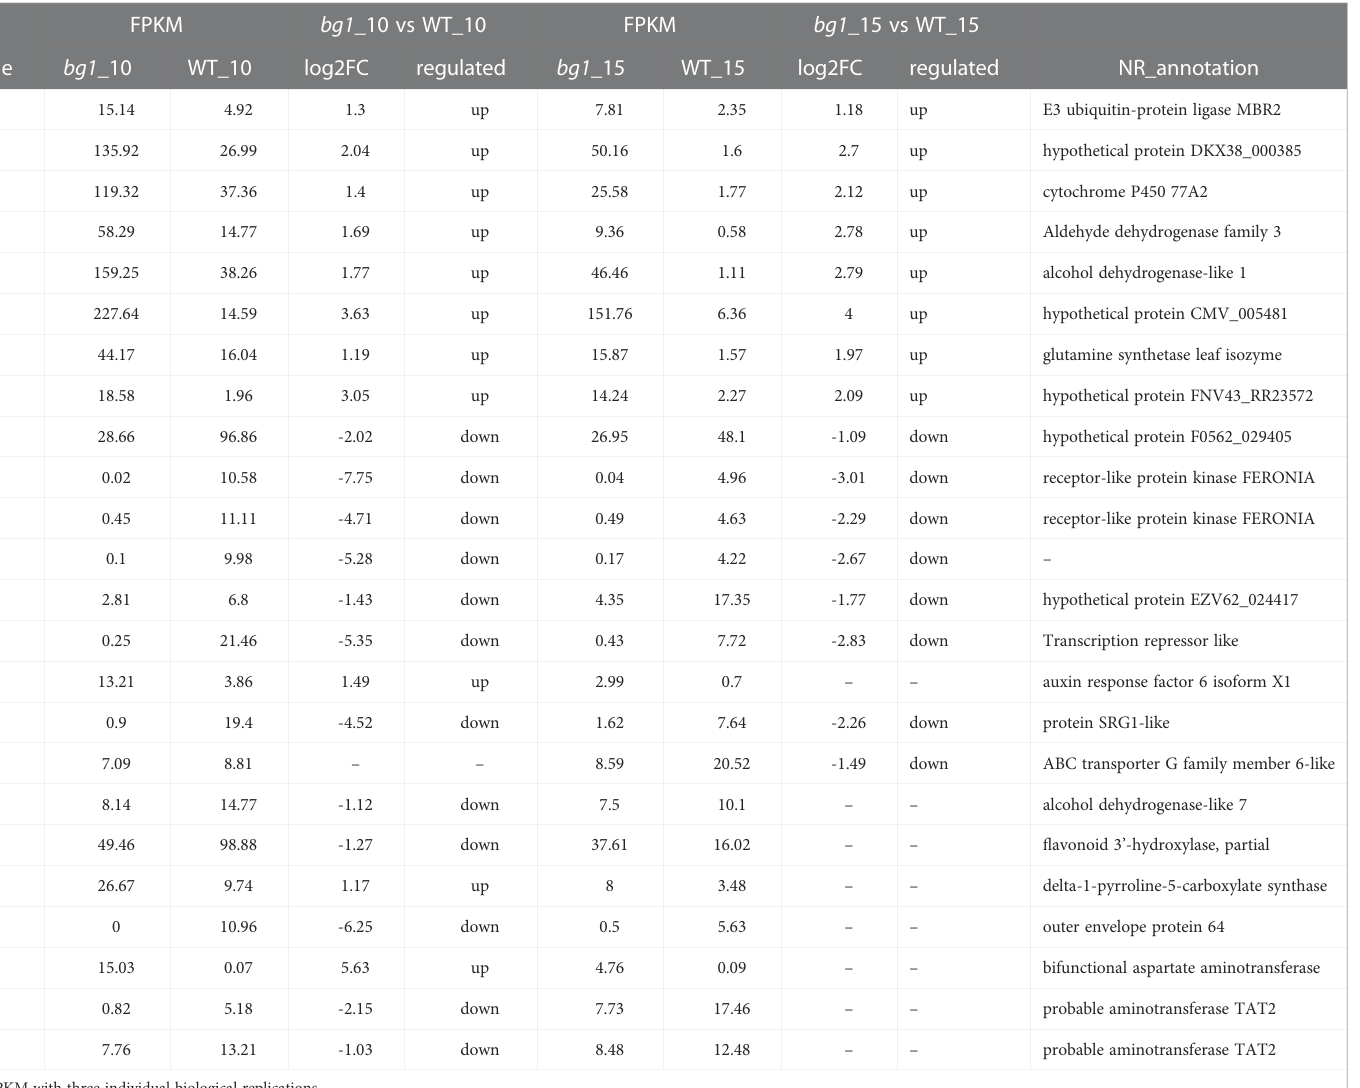
TABLE 3 Expression and functional annotation of candidate genes.